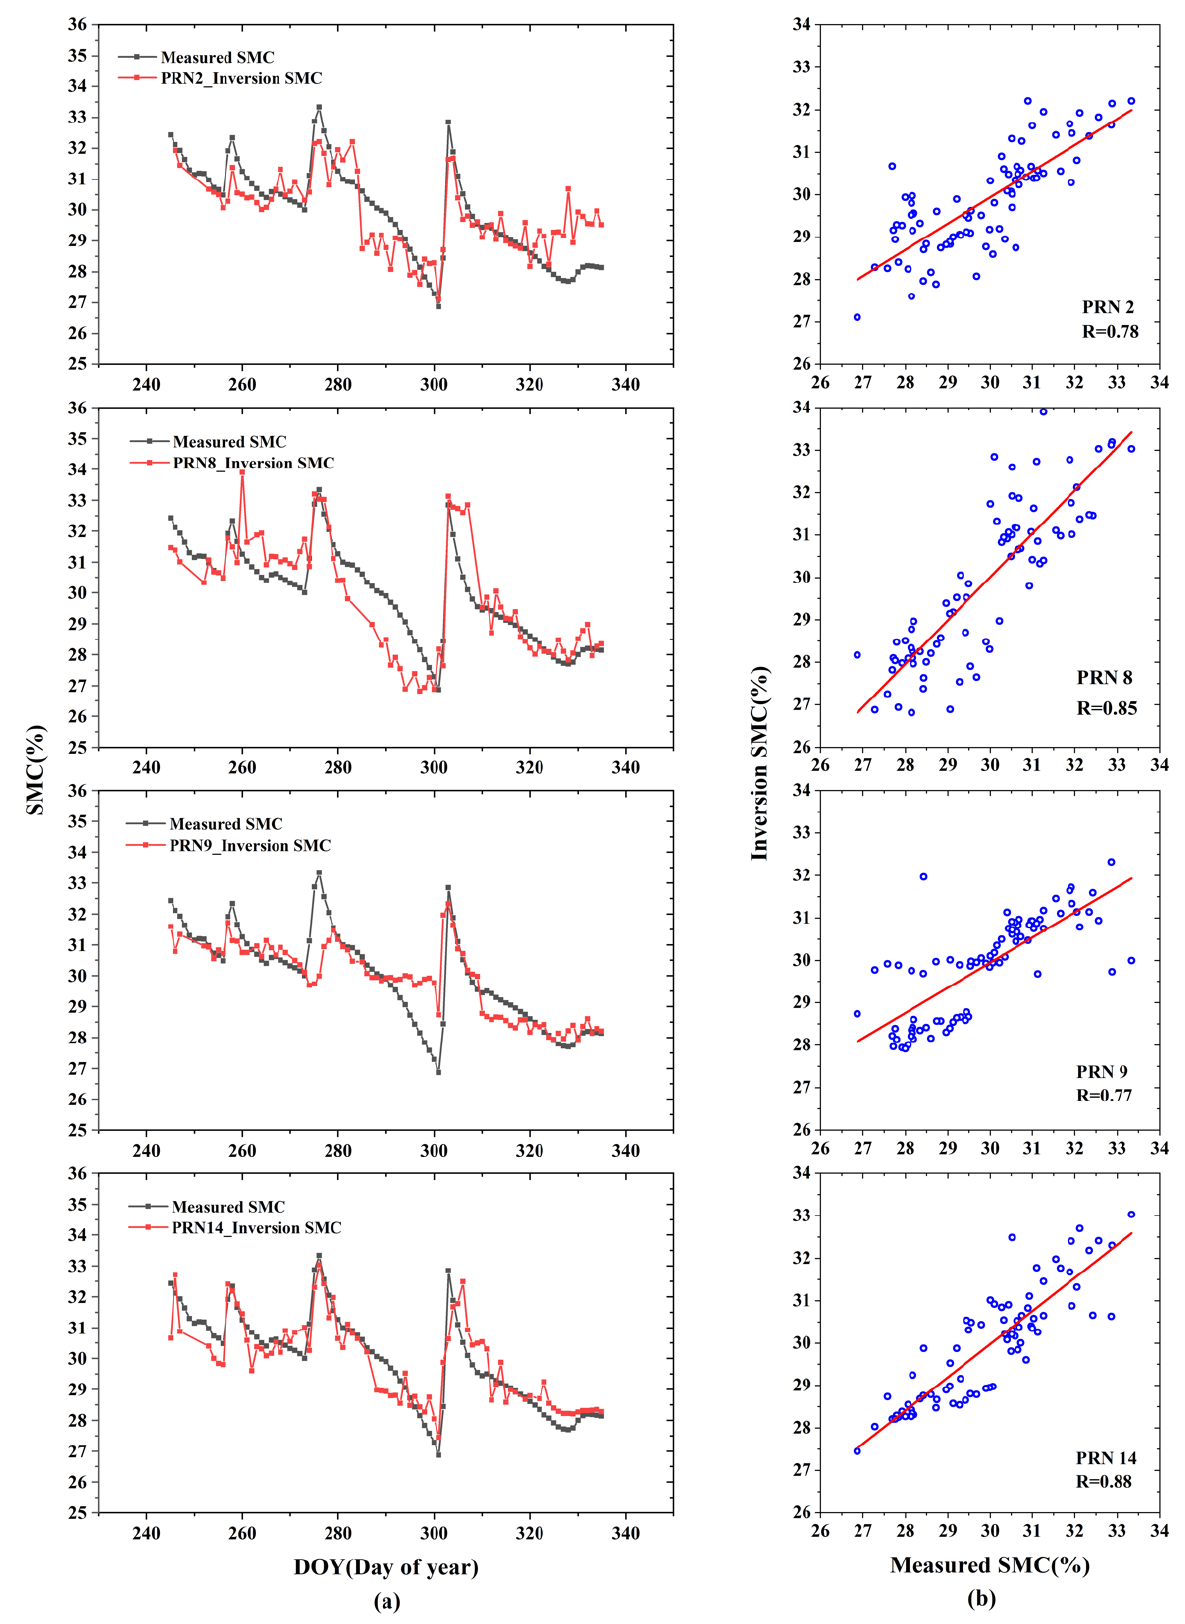
Figure 11. ( a ) Comparison results of soil moisture by satellite interpretation and measured soil moisture. ( b ) Correlation analysis between measured soil moisture and inverse soil moisture.